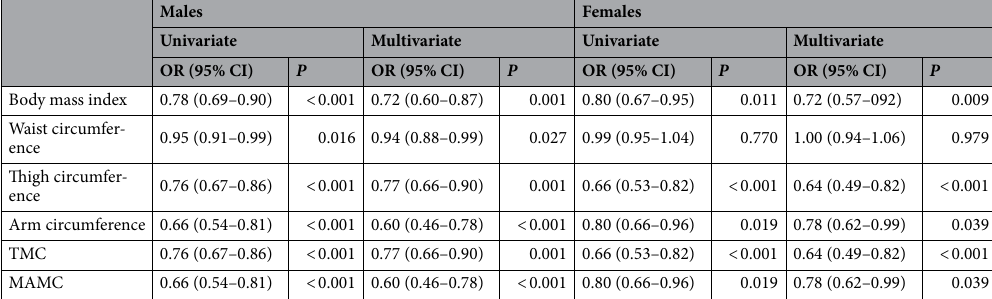
Table 3. Logistic regression analyses for sarcopenia according to indices. Multivariate analysis was adjusted for age, presence of diabetes mellitus, weekly Kt/V urea , urine volume, serum albumin, C-reactive protein, and use of automated peritoneal dialysis. Abbreviations: OR, odds ratio; CI, confidence interval; MAMC, mid-arm muscle circumference; TMC, thigh muscle